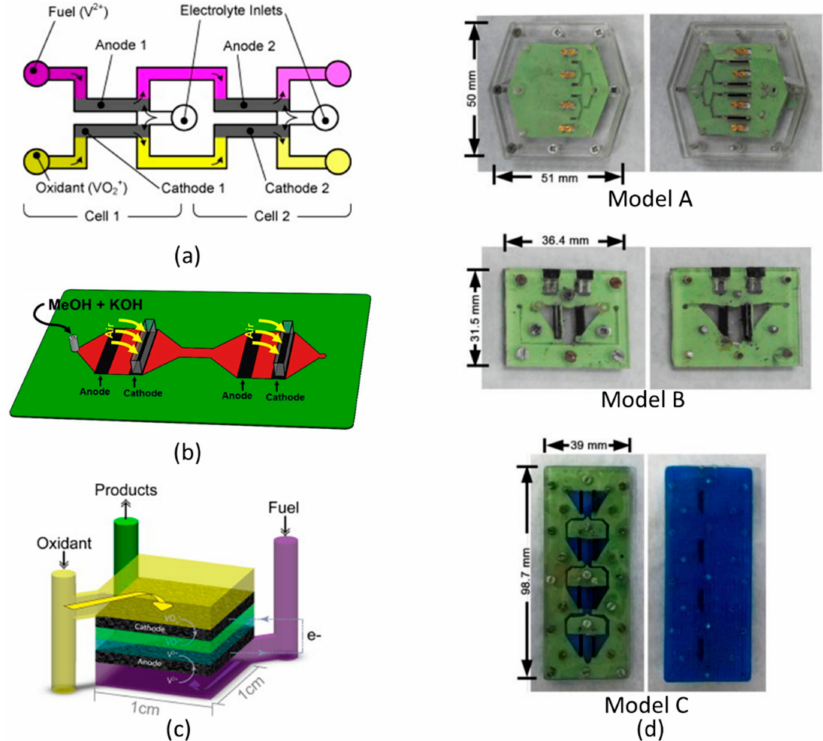
Figure 12. Evolution of MMFC stack: ( a ) multi-pass MMFC stack (reprinted from ref. [169]. Copyright 2011 Elsevier), ( b ) reactant flow in a mixed reactant microfluidic stack (reprinted from ref.